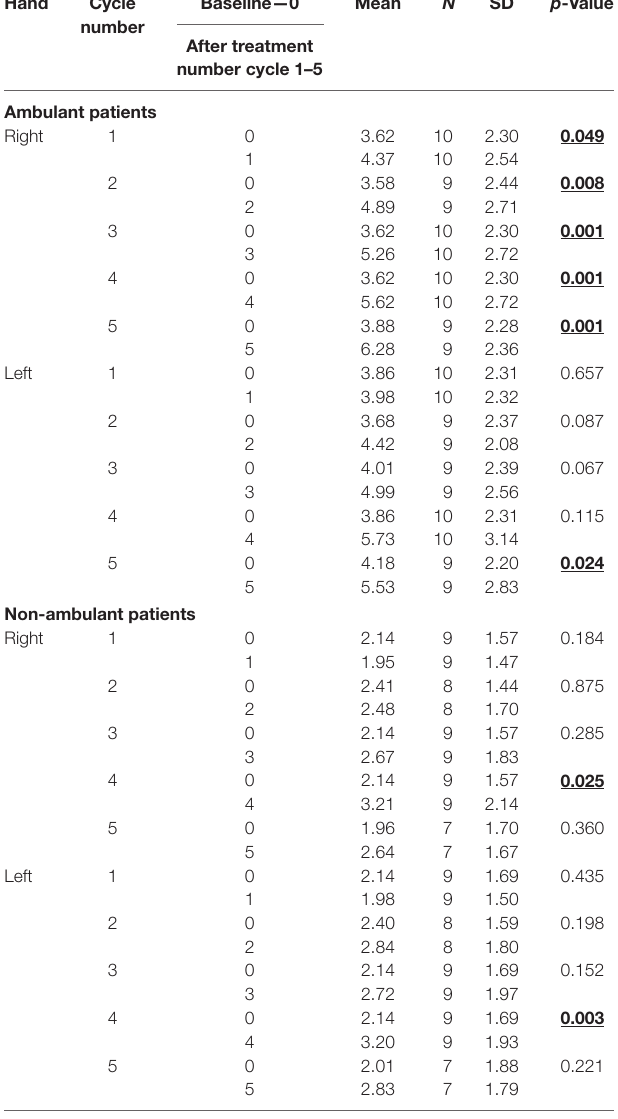
(19). G-CSF increase the proliferation of satellite cells, with transformation into myotubes and muscle fibers, and promote of muscle regeneration (11, 20). These results may point to the general activation of the entire system of cellular regulation rather than a specific target. It has been shown that G-CSF decreases inflammatory